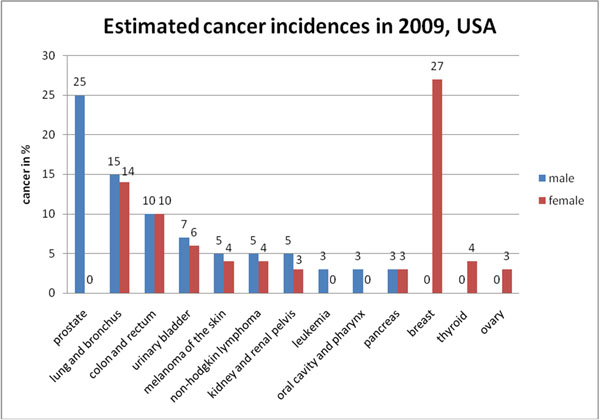
Cancer incidence as recorded in the USA, 2009 [1].